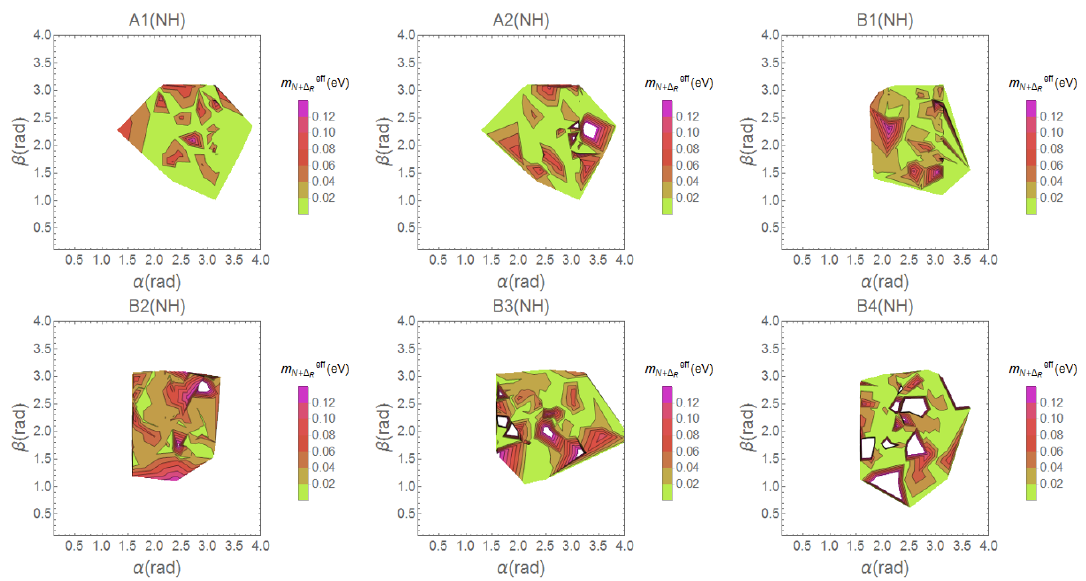
JHEP02(2019)129 Figure 6 . New physics contribution to e(cid:11)ective mass governing NDBD for di(cid:11)erent classes of two zero textures for NH shown as a function of two parameter (cid:11) and (cid:12) . The contour represents the e(cid:11)ective Majorana mass where 0.061 eV is the KamLAND-Zen upper limit. Figure 7 . New physics contribution to e(cid:11)ective mass governing NDBD for di(cid:11)erent classes of two zero textures for IH shown as a function of two parameter (cid:11) and (cid:12) . The contour represents the e(cid:11)ective Majorana mass where 0.061 eV is the KamLAND-Zen upper limit. { 19